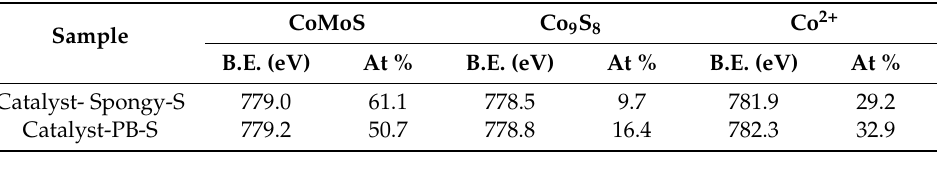
XPS analysis results of the different contributions of Co2p to Catalyst-Spongy-S and Catalyst-PB-S.